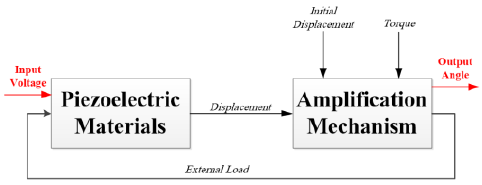
Figure 3. The combined system scheme [24].